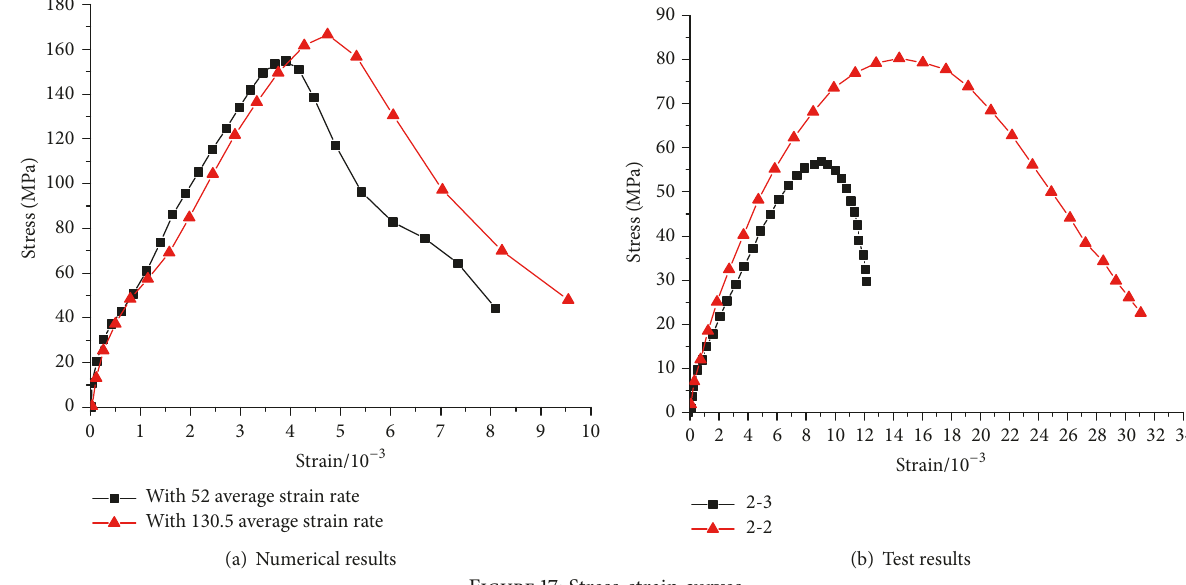
Figure 17: Stress-strain